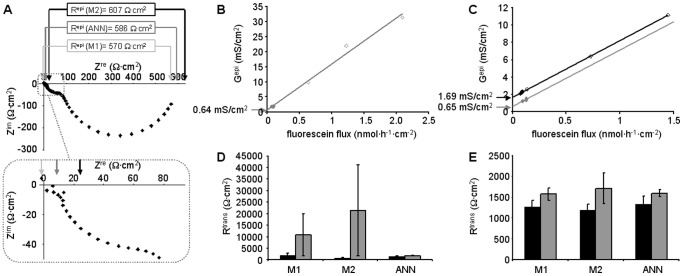
Applicability of 2PI under conditions of altered Rap or Rbl.
A) Nyquist plot of HT-29/B6 impedance spectrum after the application of forskolin. Arrows indicate estimates of Rsub (see inset) and RT using the three methods, M1 (light grey), M2 (dark grey) and ANN (black). RT = Repi+Rsub. B,C) 2PI: Plotting epithelial conductance Gepi = 1/Repi (♦, in the absence; ♦, in the presence of forskolin; ⋄, after EGTA application) against transepithelial fluorescein flux allows estimate of transcellular conductance, Gtrans
[5]. (B) Experiment without forskolin application. Gtrans equals y-intercept (arrow) of the linear regression (grey line, Gtrans = 0.64 mS/cm2). (C) Gtrans in the presence of forskolin is obtained from the y-intercept (black arrow) of the linear regression (black line, Gtrans = 1.69 mS/cm2). Shifting the linear regression to pass through the values obtained before the application of forskolin (grey line) allows estimate of Gtrans in the absence of forskolin (grey arrow, Gtrans = 0.65 mS/cm2). D) Comparison of Rtrans values obtained from 30 experiments (15 without and 15 with forskolin or nystatin application, black and grey bars, respectively), using the three methods to estimate Repi. Four experiments (three without and one with nystatin application) yielded negative or unreasonably high Rtrans values when evaluated with methods M1 and M2. E) Same as (D) but after omission of these four experiments. Remaining estimates from experiments without forskolin or nystatin application were very similar for all three methods, estimates from experiments with forskolin or nystatin application showed lowest variance when evaluated by ANN.